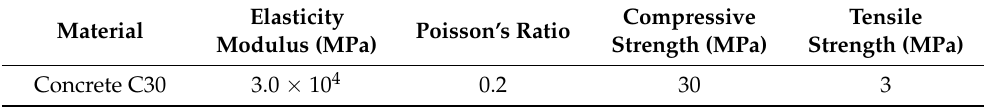
Table 5. Concrete properties.